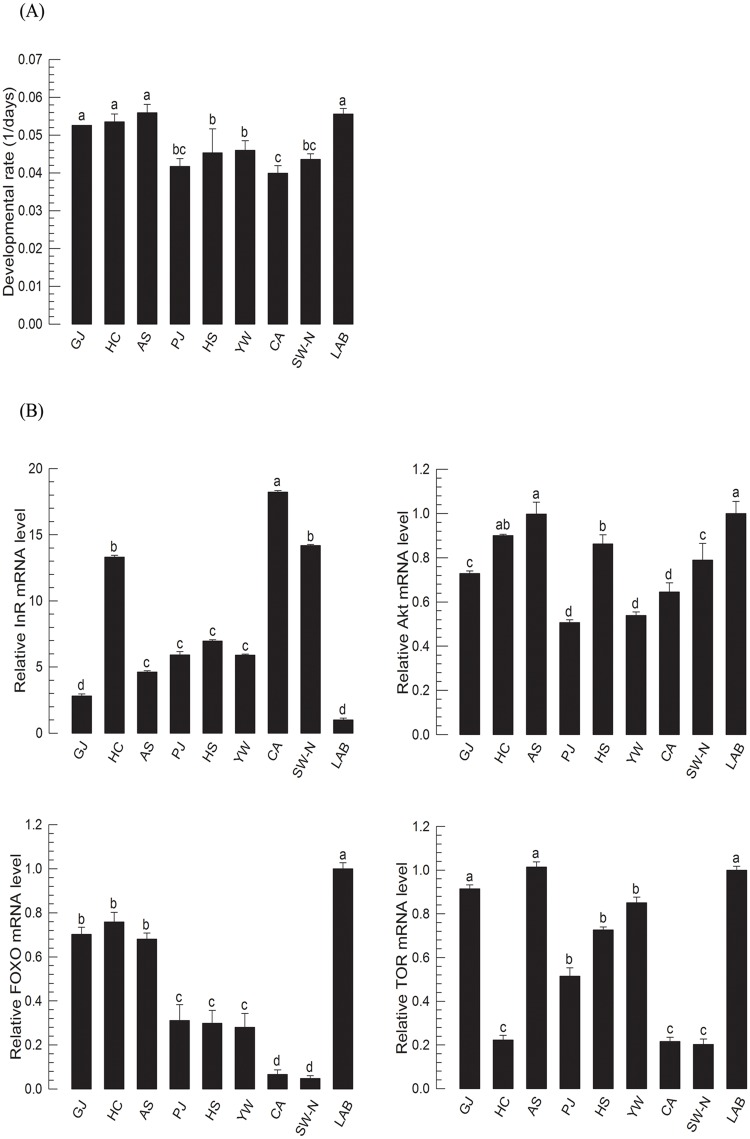
Effect of different genetic backgrounds on larval growth of M. vitrata.Growth patterns of M. vitrata larvae were obtained from a laboratory strain reared with artificial diet (‘LAB’) and eight local populations: Gyoungju (‘GJ’), Hongchun (‘HC’), Ansan (‘AS’), Paju (‘PJ’), Youngwol (‘YW’), Hoeungsung (‘HS’), Suwon (‘SW-N’), and Chonan (‘CA’). (A) Variation in larval growth of different local populations under the same rearing conditions at constant temperature 25°C with a standard artificial diet. Developmental rate was calculated by inverse of the total larval period (days). Each local population treatment used 30 larvae. (B) Change in expression levels of four IIS component genes (InR, Akt, FOXO, and TOR). These four genes’ expression levels in L5D1 larvae of eight local populations reared at constant temperature of 25°C and a standard artificial diet from L1 were quantified. Each treatment used nine randomly selected larvae. mRNA levels were relatively quantified and compared to mRNA level in L5D1 larvae reared in the laboratory with artificial diet. Actin was used as reference gene of RT-qPCR to normalize target gene’s expression level. Different letters above standard deviation bars indicate significant difference among means at Type I error = 0.05 (LSD test). (C) T-test between the expected larval period (L1D1-L5D5) from regressions obtained from IIS gene expression levels and the observed larval period (L1D1-L5D5). Asterisk indicates significant difference between expected and observed values. ‘NS’ represents no significance at Type I error = 0.05.